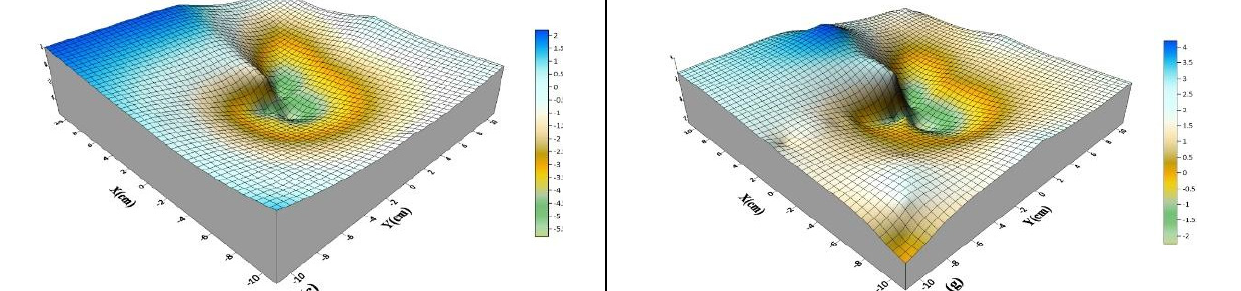
Fig. 8(g): The Scour and Deposition Pattern around Pier (P 2 ) at angle 12 0 and flowrate 9L/Sec.